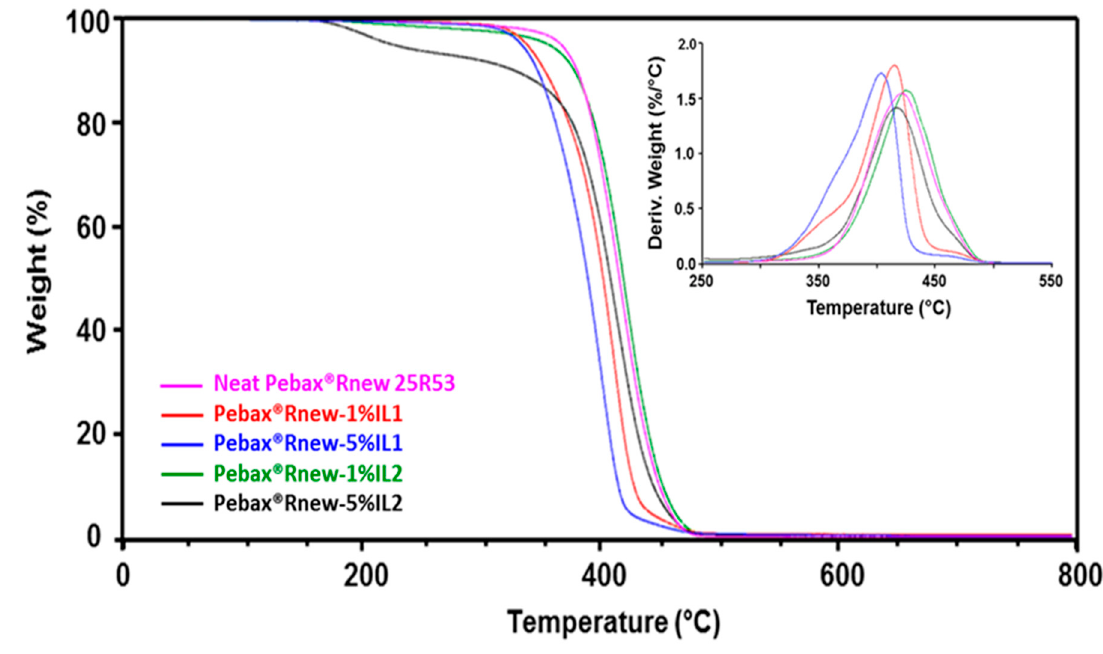
Figure 3. Thermogravimetric and DTG (inset) curves of Pebax ® Rnew and Pebax ® Rnew/ILs blends. Table 2. Thermogravimetric data of neat Pebax ® Rnew and its blends.